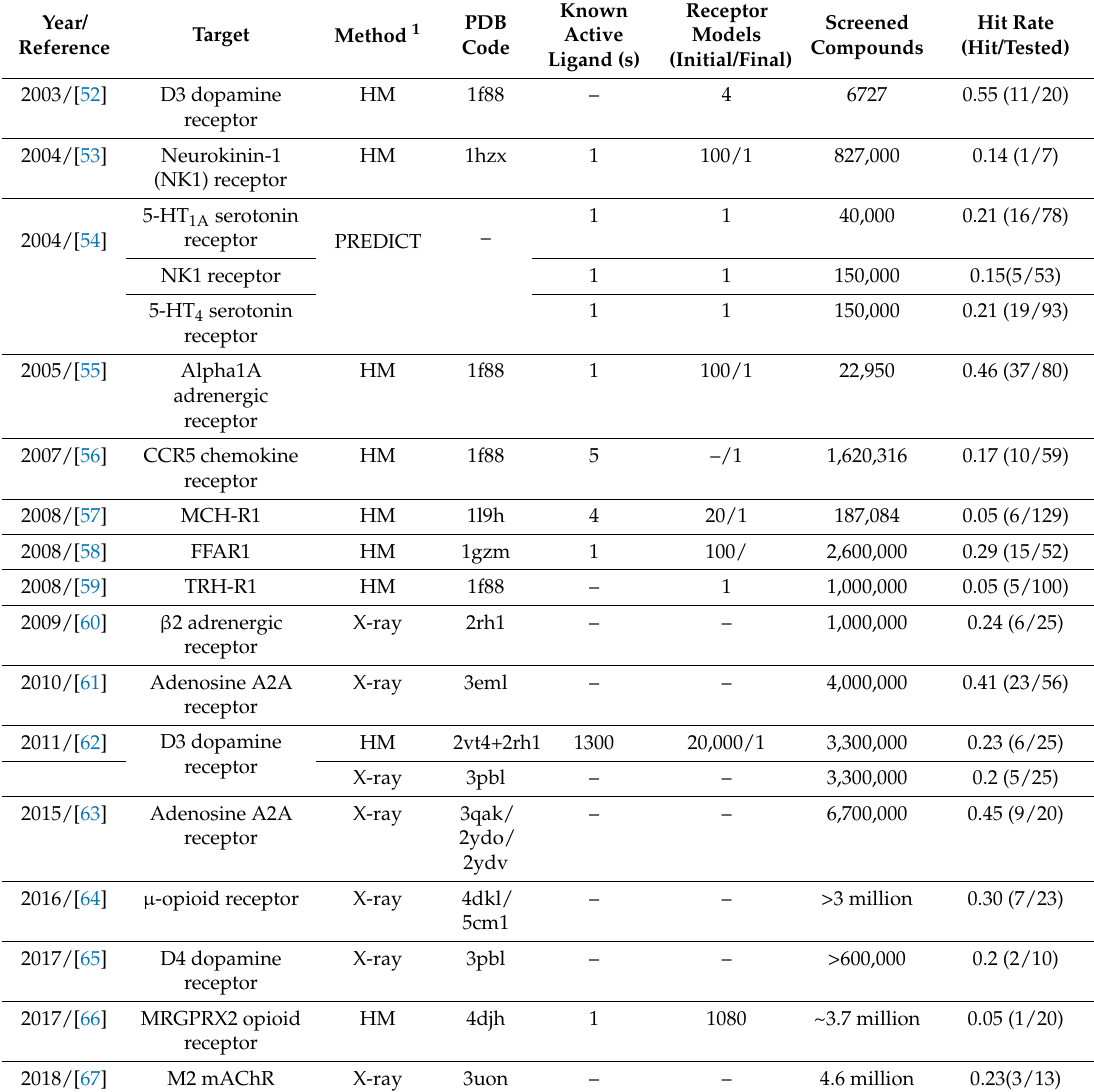
Table 1. Examples of docking campaigns for the discovery of G protein-coupled receptors